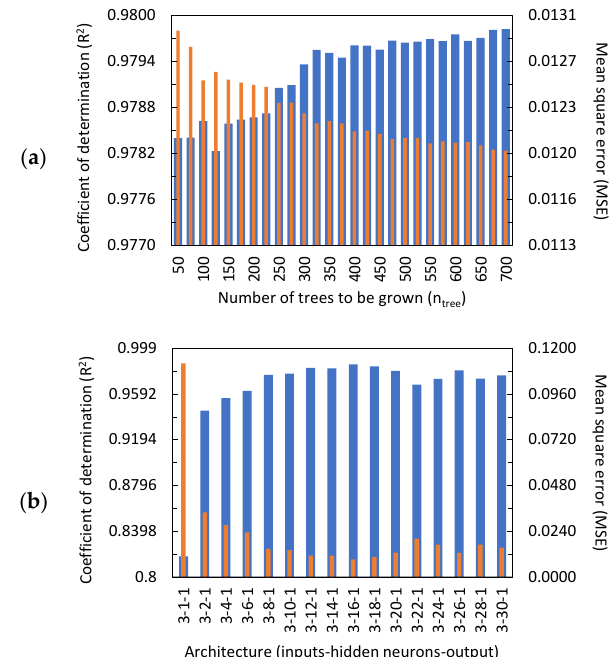
Figure 6. Performance measures ( R 2 and mean square error (MSE)) to evaluate the accuracy of ( a ) the random forest (RF) at di ff erent random of trees to be grown (n tree ) and ( b ) the feedforward neural network (FNN) at di ff erent architectures (inputs-hidden neurons-output). Blue bars represent R 2 (left axis), and orange bars represent MSE (right